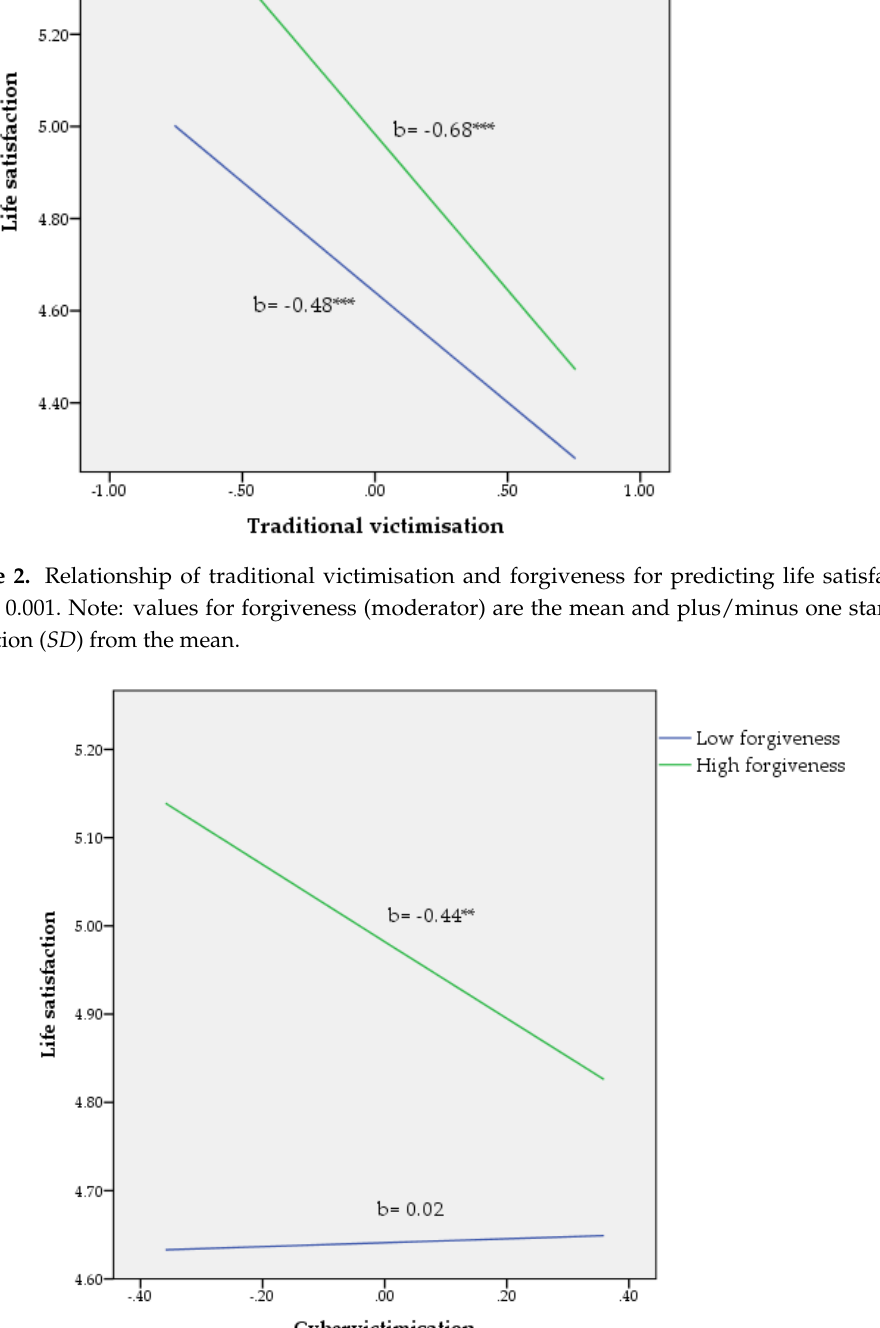
Figure 3. Relationship of cybervictimisation and forgiveness for predicting life satisfaction. ** p < 0.01. Note: values for forgiveness (moderator) are the mean and plus/minus one standard deviation ( SD ) from the mean.